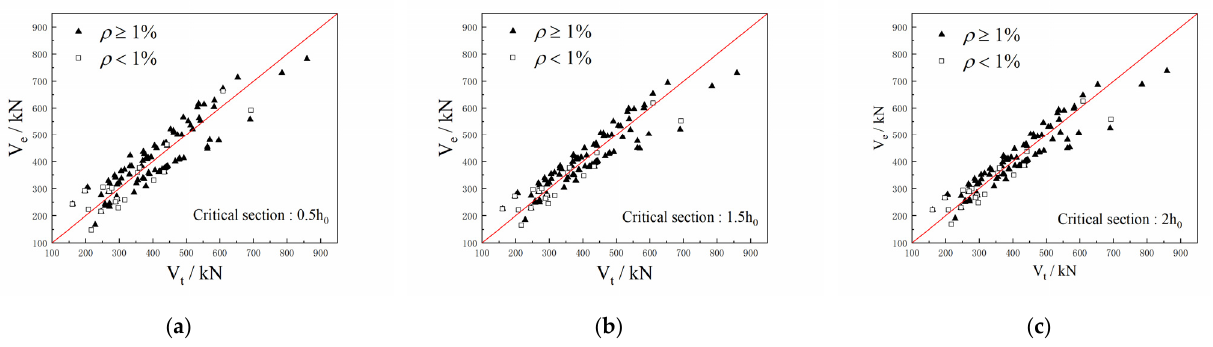
Figure 13. Punching shear capacity of different critical section perimeter: ( a ) u m = 4 ( c + h 0 ); ( b ) u m =